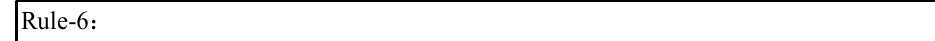
Figure 8. Reasoning the security status of the IoT environment.